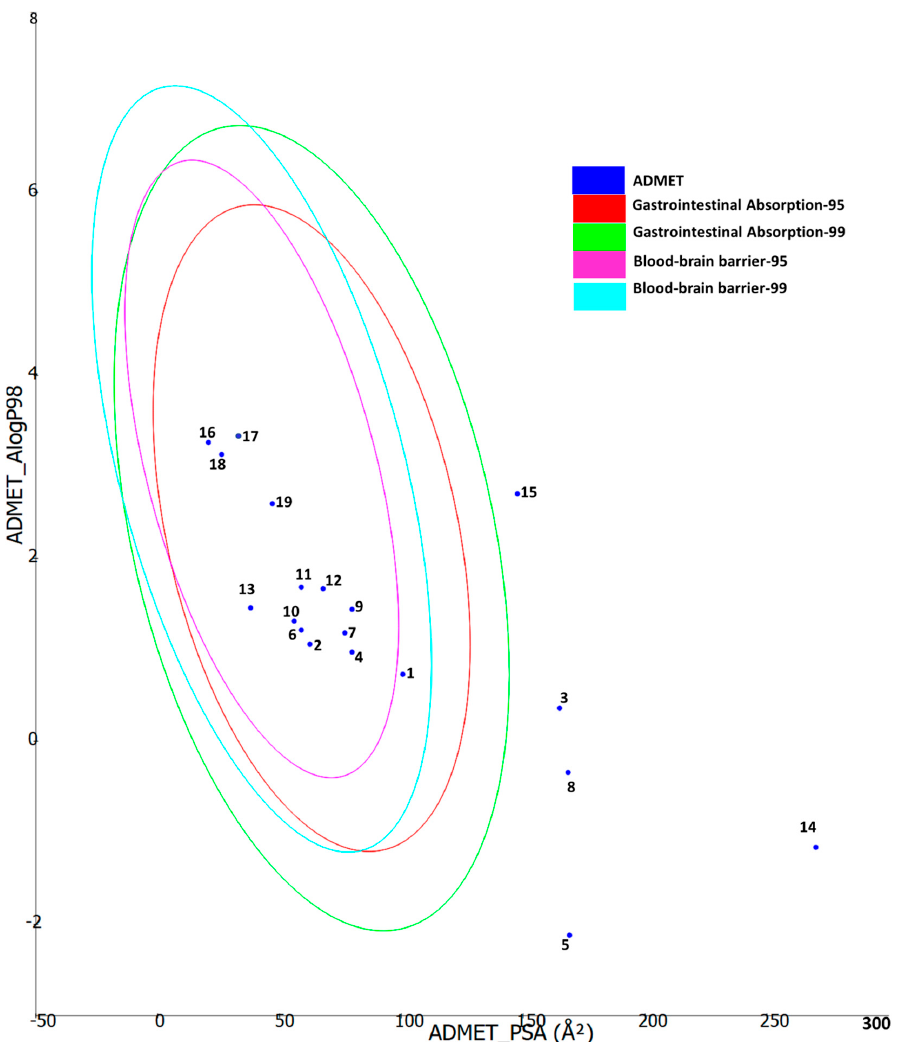
Figure 9. ADMET properties of the bioactive compounds extracted from Pelargonium quercetorum predicted using Biovia DS ADMET prediction toolkit. The four ellipses enclose areas where well- absorbed compounds should be found: at 95 and 99% confidence levels for gastrointestinal absorption (red and green), and blood-brain barrier penetration (magenta and aqua). The compounds are shown according to their serial number in Table 2.